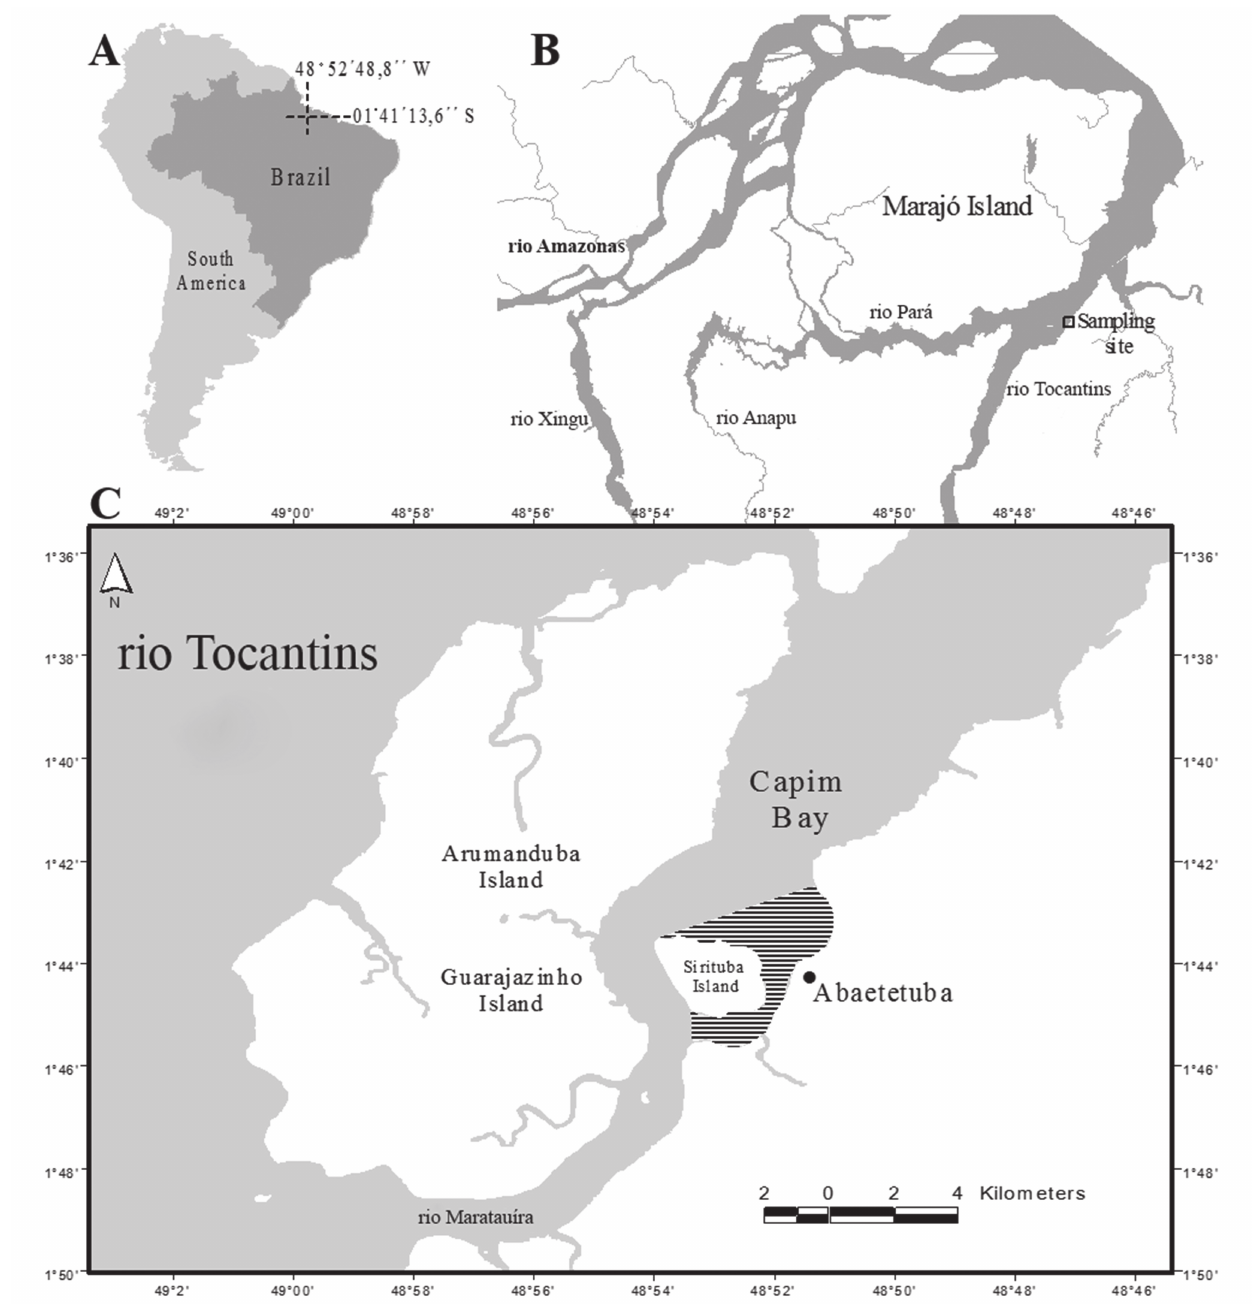
Fig. 1. Location of study area near the mouth of the rio Amazonas in Brazil. A, Location of Brazil on South America; B, rio Amazonas mouth with the sampling site; C, Study area (specimens were collected within the shaded